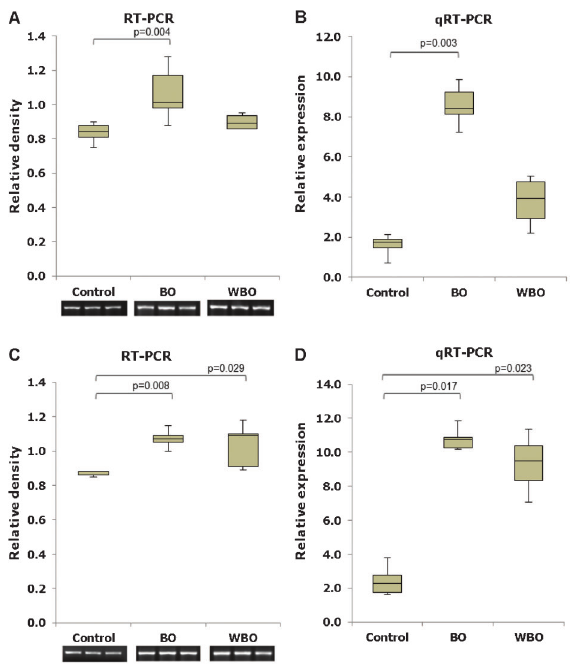
Figure 3. Gene expression profile of alpha smooth muscle actin ( a -SMA ) from control rats, BO and WBO parenchymas. A , C , Semiquantitative analysis (RT-PCR) of the relative density at 7 days ( A ) and 60 days ( C ) after selective ligation of the bile duct. B , D , Quantitative analysis (qRT-PCR) at 7 days ( B ) and 60 days ( D ) after selective ligation of the bile duct. The gene expression values were obtained by relative quantification using the 2 - DD ct method. One-way ANOVA was used for the comparisons of the semiquantitative method and the Kruskal-Wallis test was used for the qRT-PCR statistical analyses.